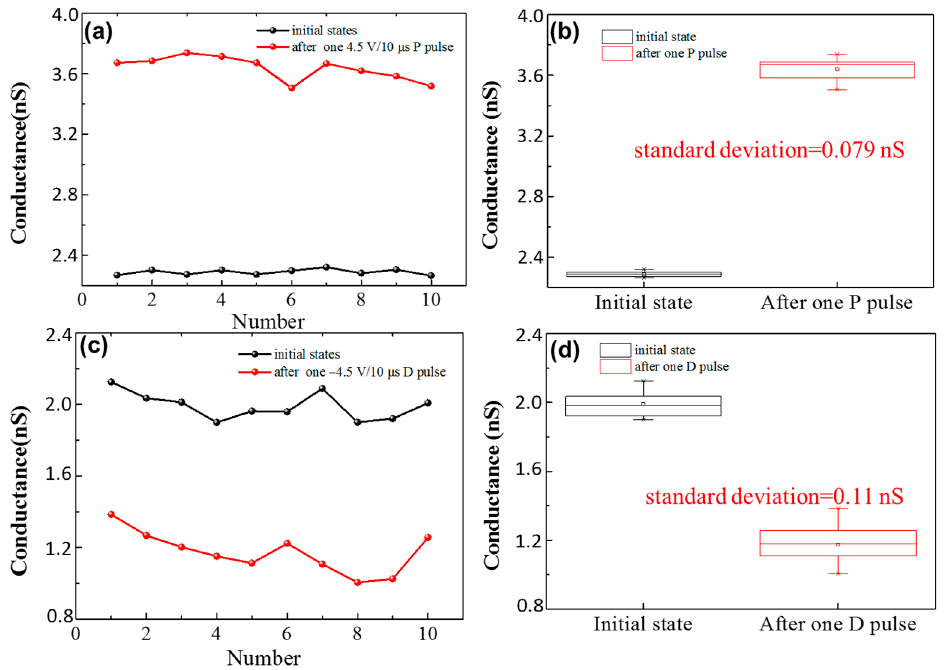
Figure 7. ( a ) The conductance states after one 5 V/10 μ s P pulse from nearly the same initial states. ( b ) Conductance distribution from (a), where the standard deviation is 0.079 nS. ( c ) The conductance states after one − 5 V/10 μ s P pulse from nearly the same initial states. ( d ) Conductance distribution from (c), where the standard deviation is 0.11 nS.